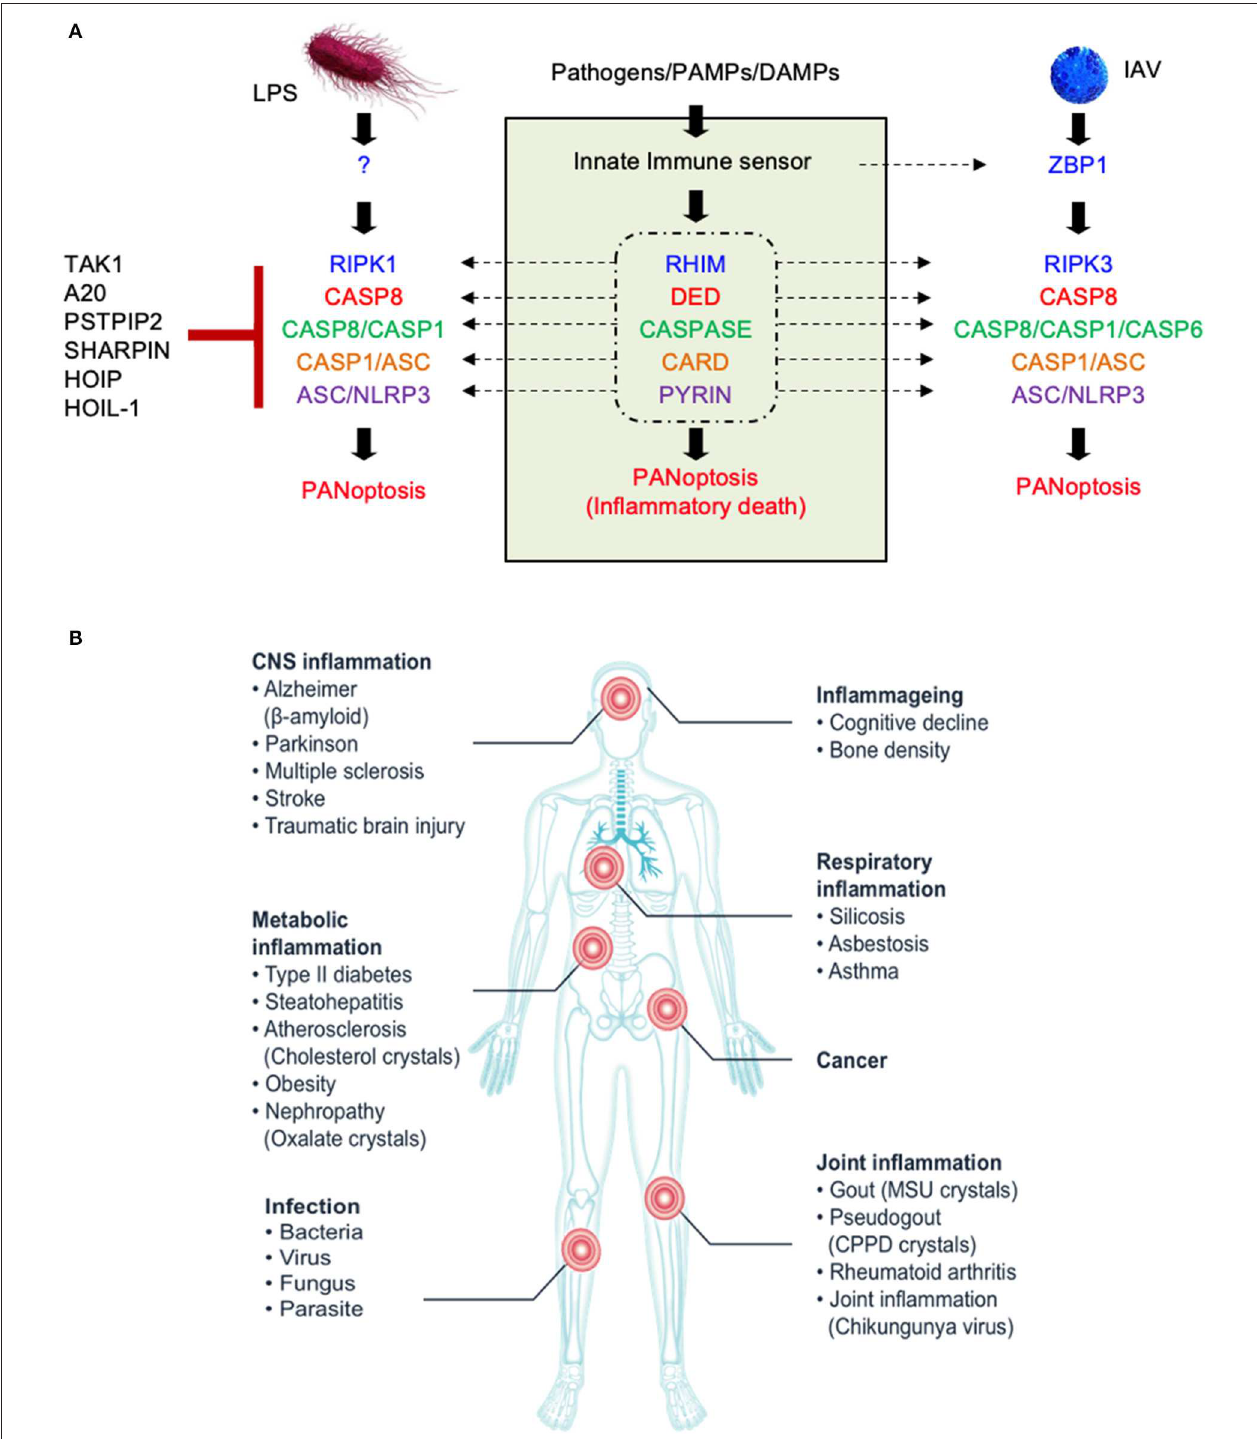
FIGURE 1 | The molecular components of the PANoptosome and the human health significance of PANoptosis. (A) Proposed domains of PANoptosome components required for complex assembly in response to various stimuli. PANoptosome assembly is mediated by key molecular motifs collectively called death fold domains. Genetic evidence suggests that PANoptosome activation is inhibited by TAK1, PSTPIP2, SHARPIN, HOIP, HOIL-1, and A20. (B) Defects in the PANoptosome components have been implicated in a range of human diseases.